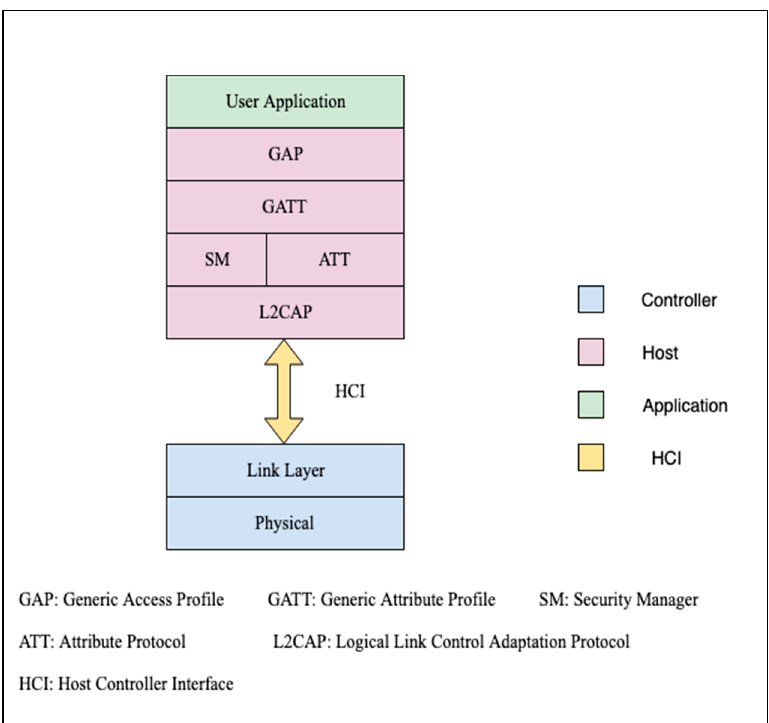
Figure 6. Bluetooth Low Energy protocol stack [8]. Reproduced with permission from Dian et al., IEEE 2018.